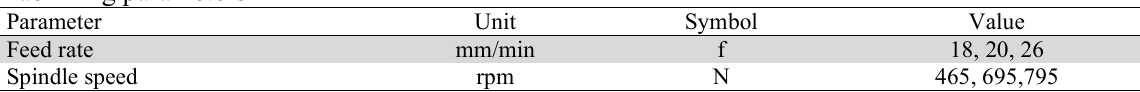
Work piece mechanical properties Parameter Unit Symbol Shear